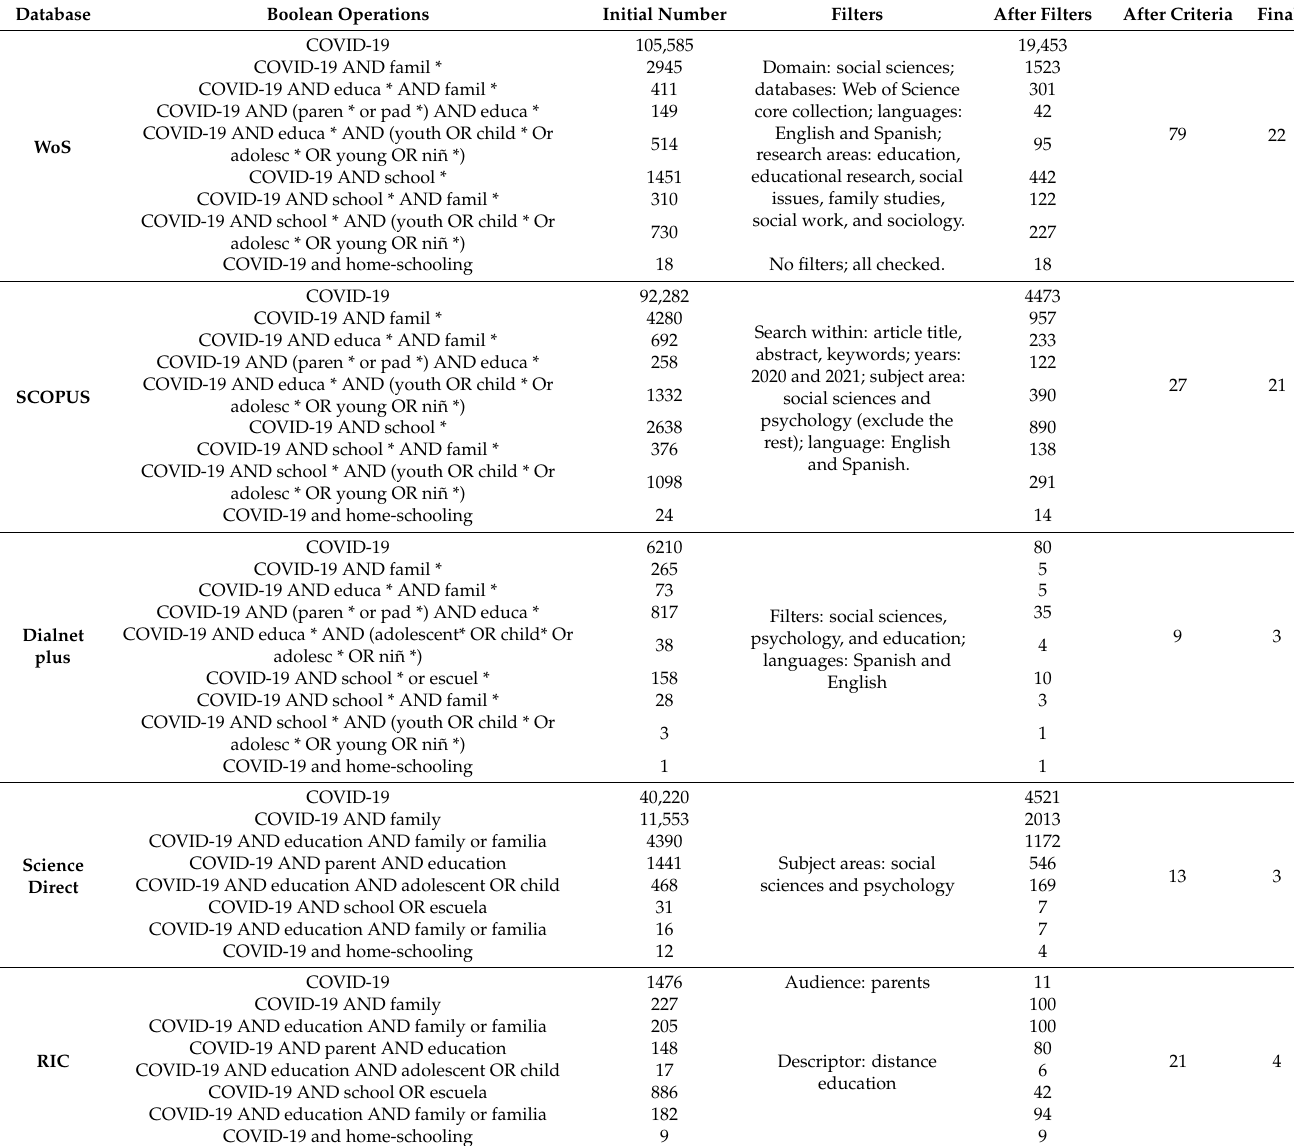
Table 1. Procedure for selecting articles from the structured search in the primary